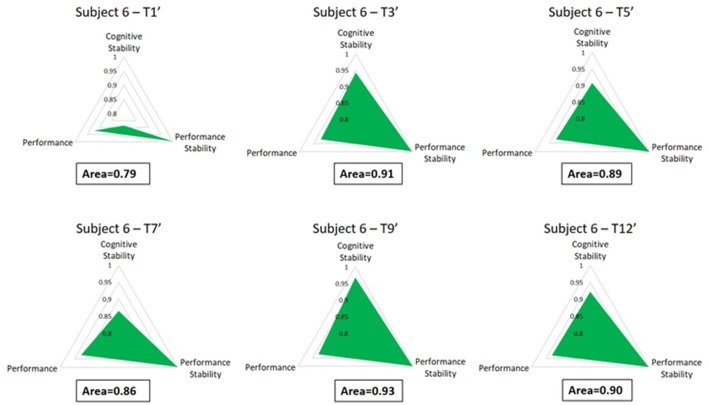
The figure reports the Areas of a representative subject along the considered training sessions. It is possible to appreciate how the Subject 6 improved its behavioral and cognitive skills from the beginning (T1) to the end of the training period (T12).